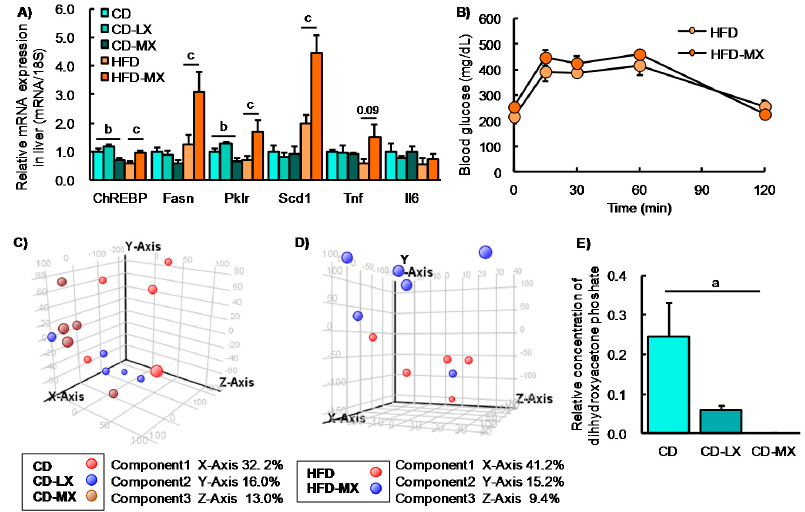
Figure 3. Hepatic gene expression, oral glucose tolerance test, and luminal metabolite in xylitol-fed mice. Relative hepatic gene expression involved in lipid metabolism in mice fed xylitol ( A ). Changes in blood glucose levels during an oral glucose tolerance test (OGTT) in mice fed xylitol with the HFD ( B ). Principle component analysis of 94 luminal metabolites in mice supplemented with xylitol and the CD ( C ) or the HFD ( D ). Changes in relative concentration of luminal dihydroxyacetone phosphate in mice supplemented with xylitol and the CD ( E ). Fasn: fatty acid synthase, Pklr: pyruvate kinase liver and red blood cell. Data represent the mean ± SEM ( n = 5–6). a: p < 0.05 between CD and CD-MX. b: p < 0.05 between CD-LX and CD-MX. c: p < 0.05 between HFD and